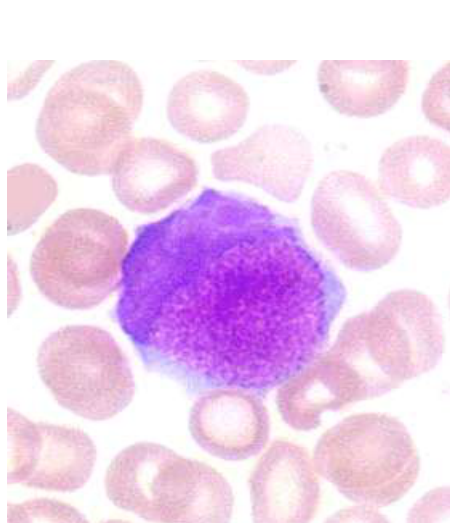
Fig.1: Neutrophil (up) and Eosinophil(Down)(Wright stain) X 100.